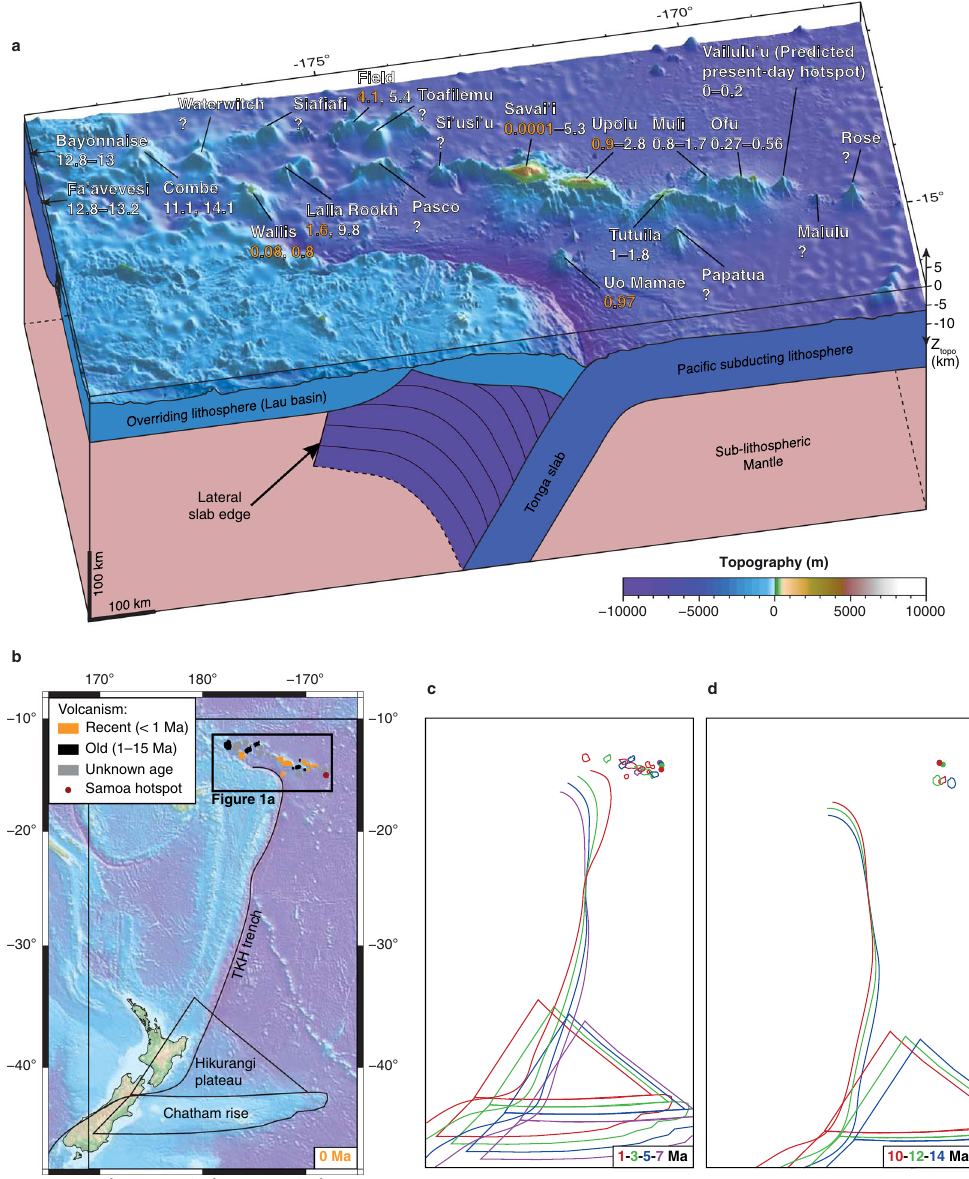
Figure 1. Unique tectonic setting and kinematics of the Samoan volcanic province, close to the Tonga- Kermadec-Hikurangi (TKH) subduction zone. ( a ) Perspective bathymetry and line drawing showing Samoan volcanoes with their name and northern slab edge of the TKH subduction zone. Numbers indicate known age of volcanism. Orange text highlights ages too young to fit the plume model. ( b ) Present-day bathymetry and main tectonic features of the TKH subduction zone. ( c , d ) Tectonic reconstruction depicting evolution of the TKH trench, the position of Samoan volcanism and of the Hikurangi Plateau and Chatham Rise at 1, 3, 5, 7 Ma ( c ) and 10, 12, 14 Ma ( d ). The topographic maps in Fig. 1a,b were created using the GEBCO_2014 Grid (version 20150318, www.gebco.net) with 0.5 arc-minute resolution and all maps were plotted using the GMT software developed by Wessel and Smith (1991) 60 (version 4.5.14, http://gmt.soest.hawaii.edu). The drawings in tectonic reconstruction maps of Fig. 1b,c,d were done using the GPlates software (version 2.0, http://www. gplates.org). A data bundle provided with the software allowed us to retrace the evolution of the TKH trench, the Pacific subducting plate, the Samoan volcanoes, the Hikurangi Plateau, and the Chatham rise 52–55 , as well as the Samoan hotspot 1,56–58 , using the global rotation model of Matthews et al . 52 and the Indo-Atlantic moving hotspot reference frame as a reference 59